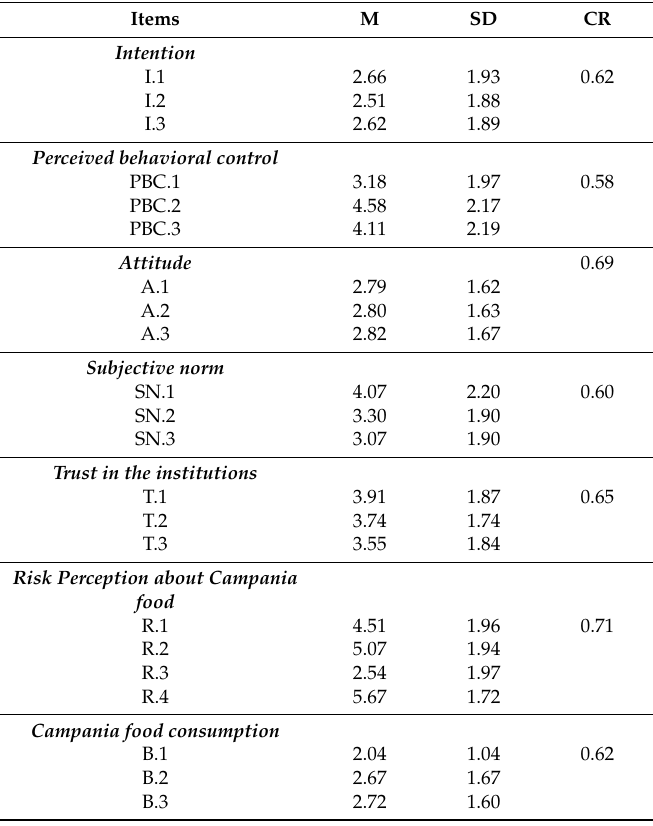
Table 2. Means and standard deviations of each